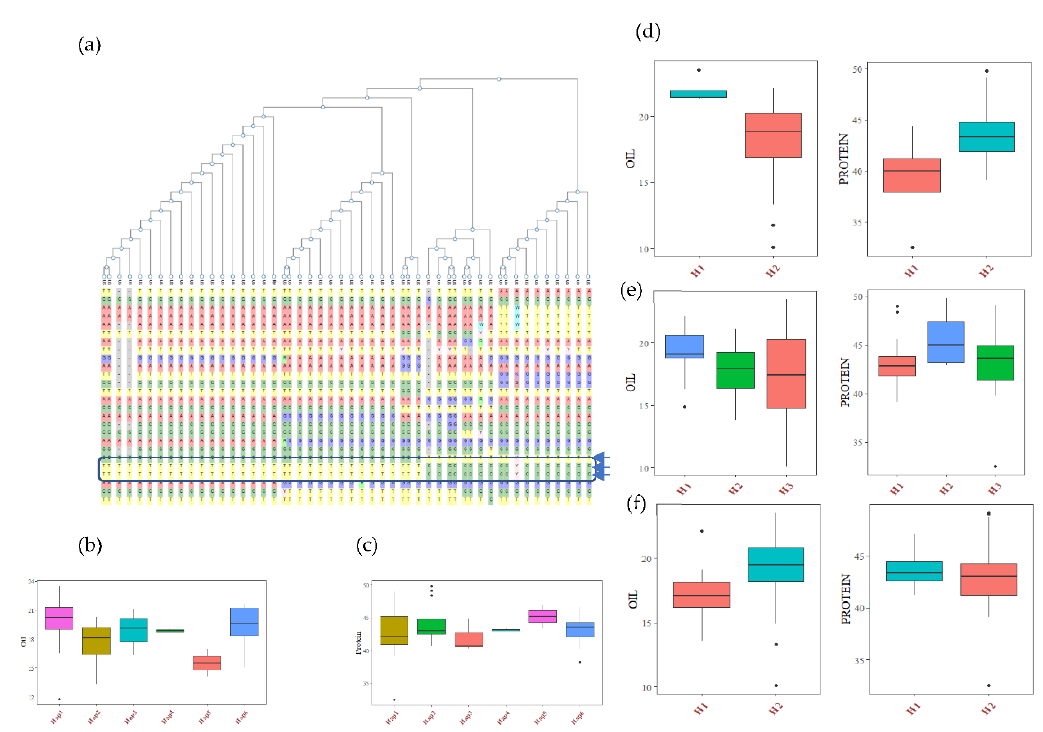
Figure 3. Haplotypic analysis of the ( a ) FAD2-1B ( Glyma.20g111000) gene, showing six haplotypic blocks. ( b ) Haplotypic association of FAD2-1B with seed oil, and ( c ) haplotypic association of FAD2-1B with seed protein. Haplotypic associations of ( d ), Glyma.13G035200 ( e ) Glyma.07G034800 and ( f ) Glyma.15G049200 with soybean seed oil and protein content.